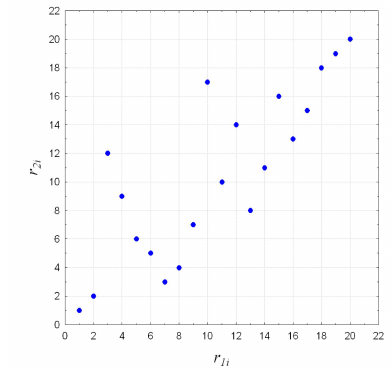
Figure 3: Graph of original data Figure 4: Graph of rank vectors